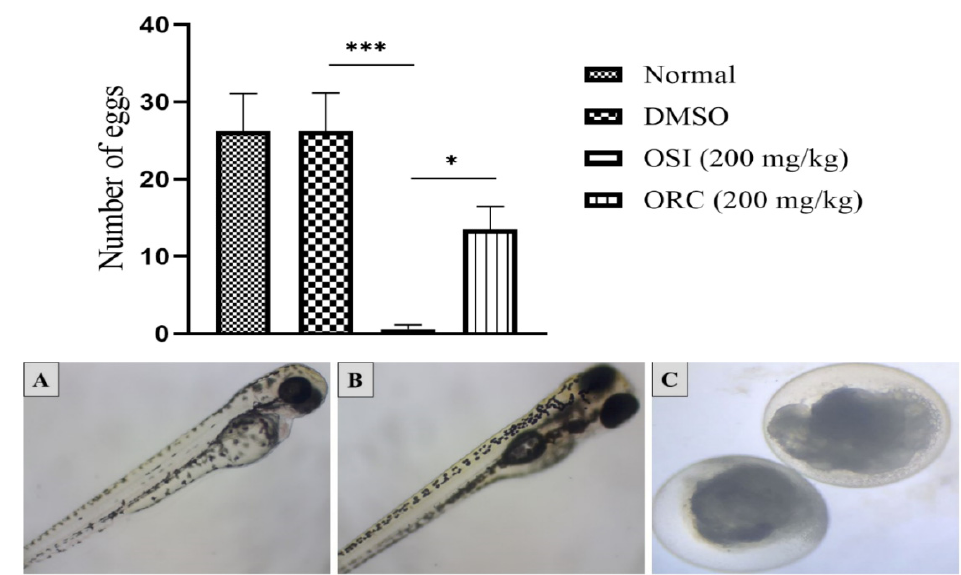
Figure 3. Top: mean ± SEM of collected eggs during 21 days of treatment (six parent fish per group); ***: p < 0.001, *: p < 0.05 (one-way ANOVA followed by the post hoc Tukey test). Bottom: ( A , B ) Representative picture of embryos from the untreated group and control groups (2% DMSO); ( C ) coagulated eggs from parental fish treated with Ormona ® SI (OSI) or Ormona ® RC (ORC) (200 mg/kg).